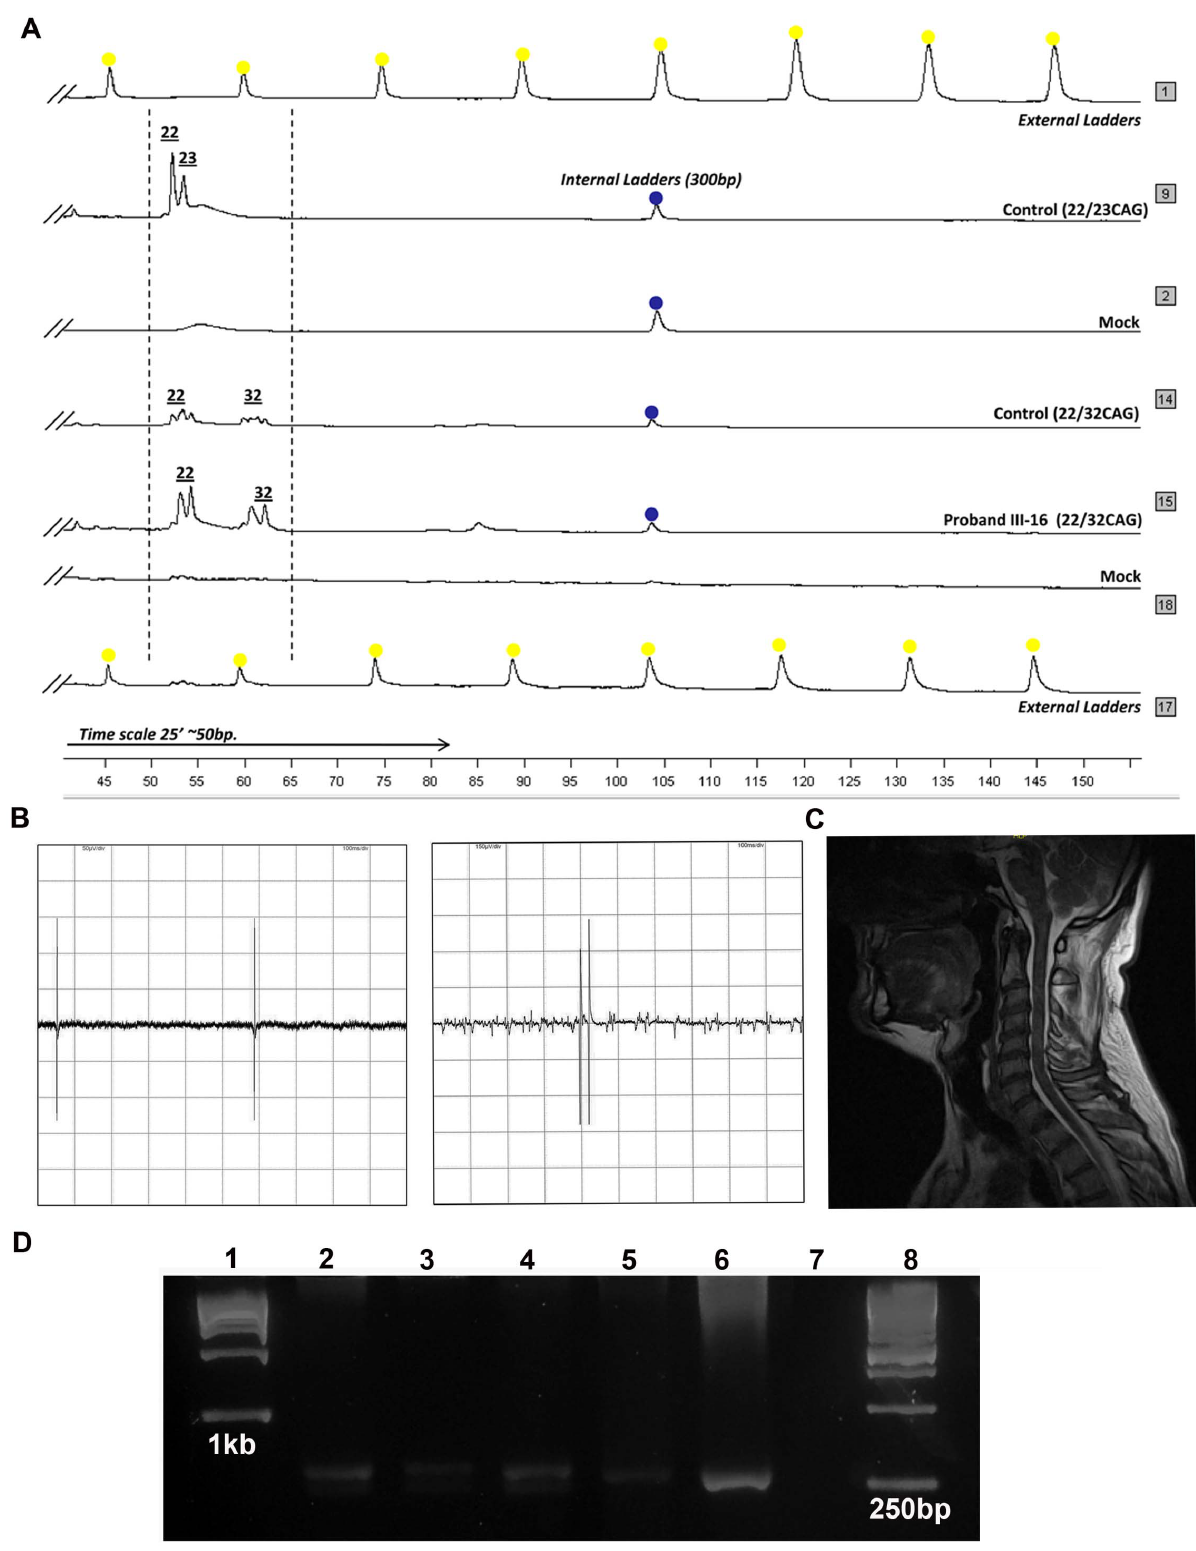
Figure 2. Genetics, EMG and MRI analysis. A) Electrophoresis of fluorescent fragment analysis of ATXN2 CAG repeat. In each lane, the content is specified. B) Fasciculation patterns in proband’s tongue and in biceps brachii recorded by EMG. C) Midsagittal MRI image of proband, no cerebellar atrophy is evident. D) Representative 3% agarose electrophoresis of C9ORF72 analysis in index case and parents (lanes 2, 3, 4). Lanes 1and 8: MW markers (Ready Load TM 1–12.216 Kb ladder and 250–3500 bp ladder in multiples of 250 bp (Invitrogen), respectively; Lane 7: mock; lanes 2, 3, 4: case III-16, and both parents II-9 and II-10, respectively. Note that each DNA showed two defined bands despite PCR products with 7-deaza-2-deoxy GTP